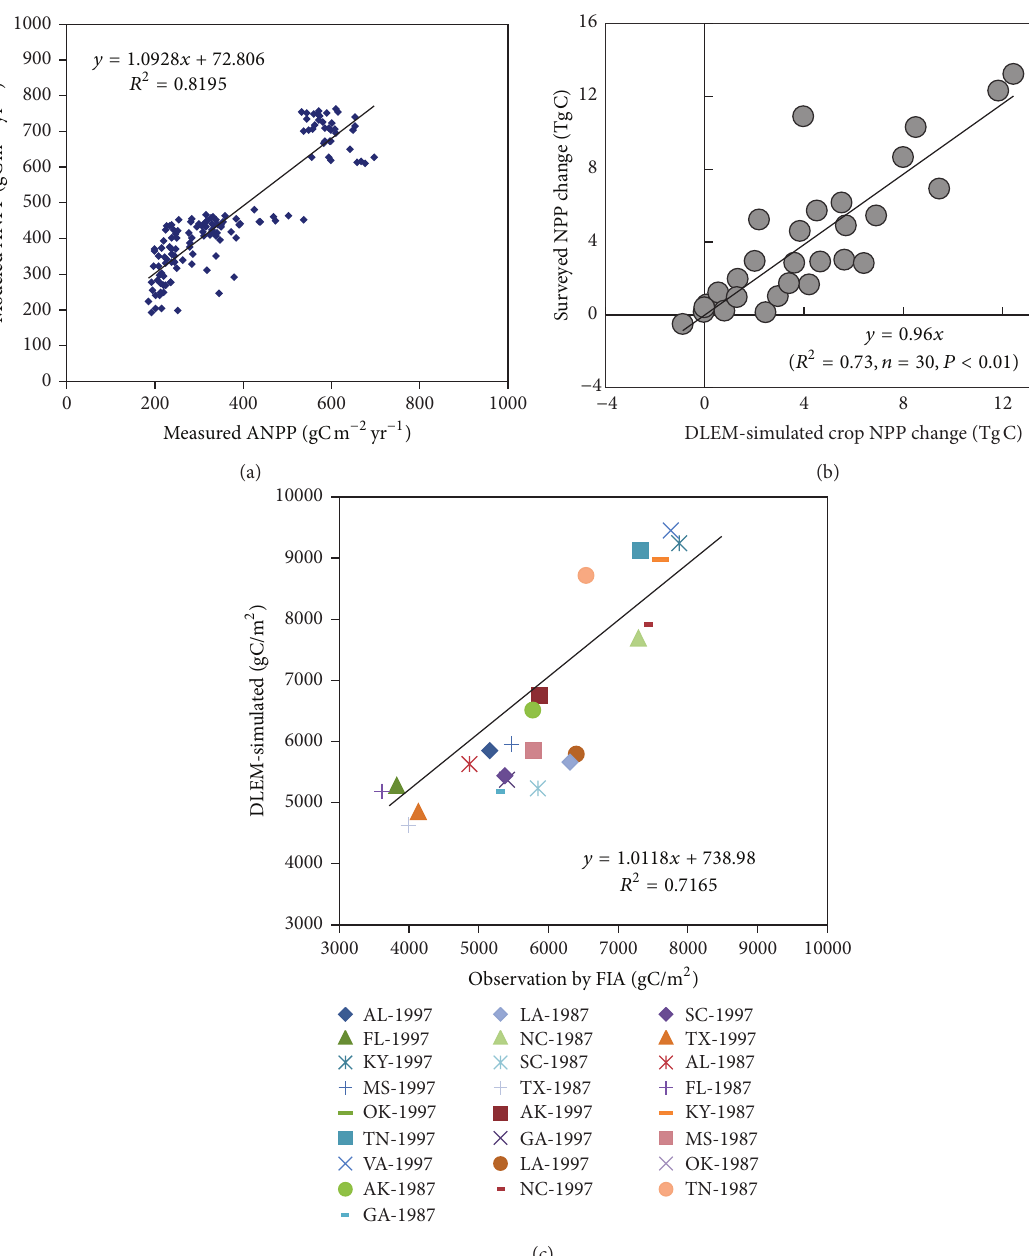
Figure 2: Comparisons of (a) modeled annual aboveground NPP against 138 field measurements in the SUS selected from Zheng et al. [120]; (b) modeled annual NPP against survey based crop NPP between 1980’s and 1990’s from Huang et al. [94]; (c) modeled vegetation carbon against forest inventory outputs in 1987 and 1997 based from Birdsey and Lewis